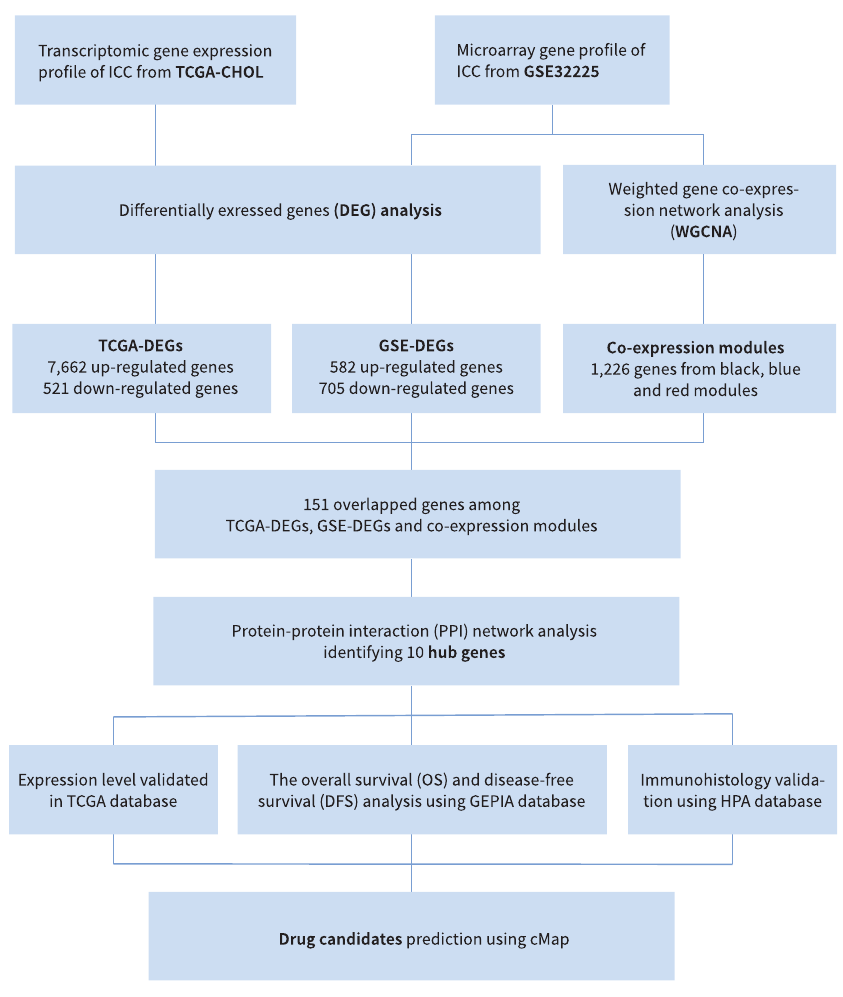
Figure 1. Study design and workflow.